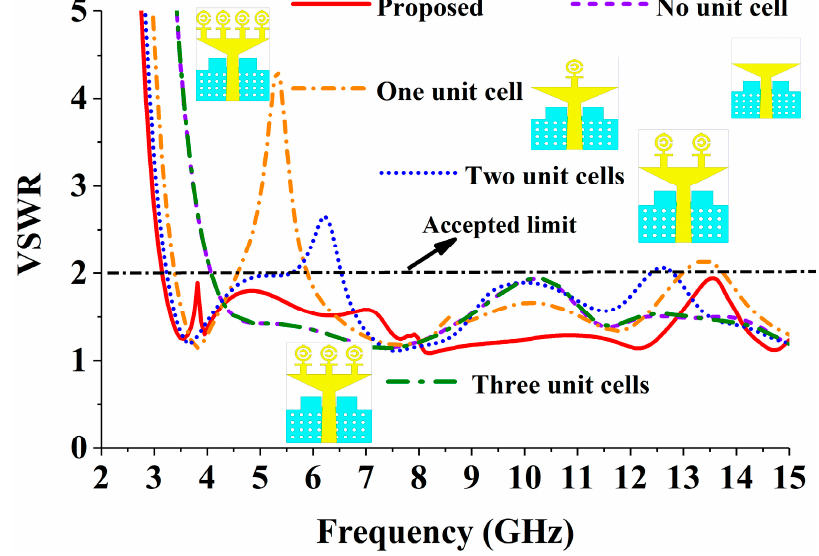
Figure 5. The effects of the unit cell of the radiating patch on the VSWR.